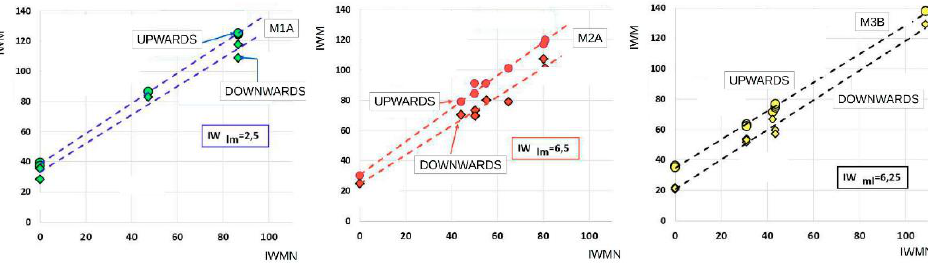
Figure 10. Graph of the values of IW M corresponding to the machines whose data were analyzed.